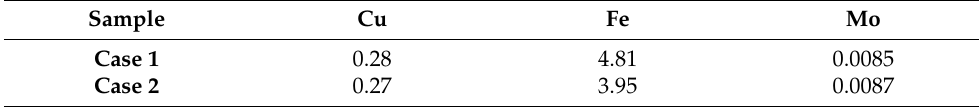
Table 3. Chemical composition of mineral ore samples (wt%).